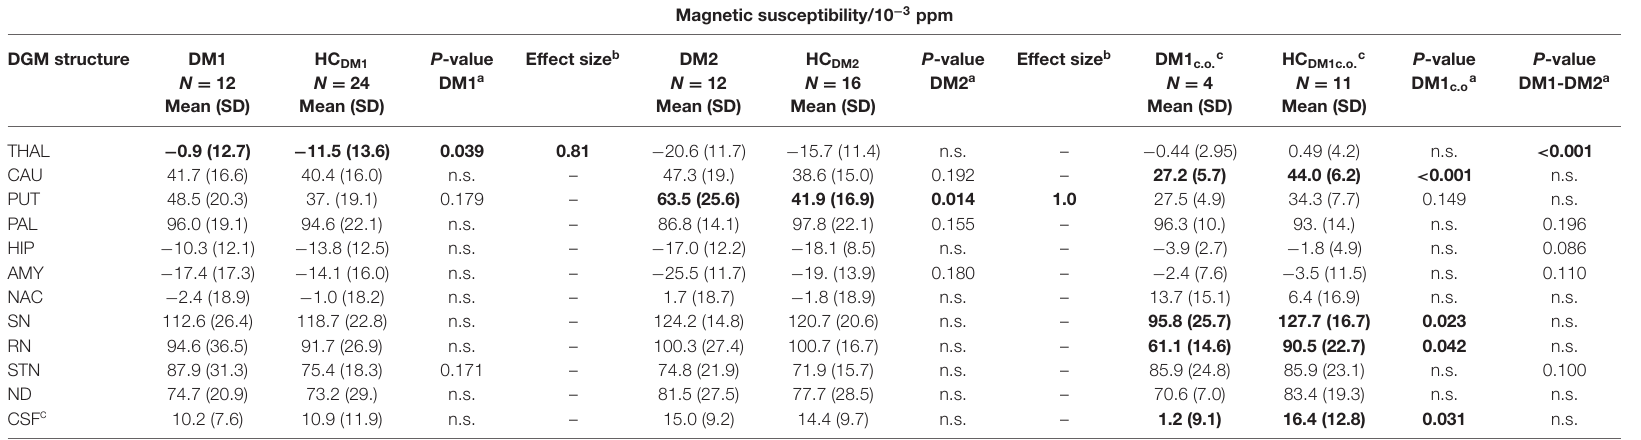
TABLE 5 | Group comparisons of the magnetic susceptibility (relative to CSF in anterior lateral ventricles) between DM1, DM2 and age matched controls (HC); in DM1 c.o . and HC DM1c.o. the susceptibility is referenced relative to whole brain